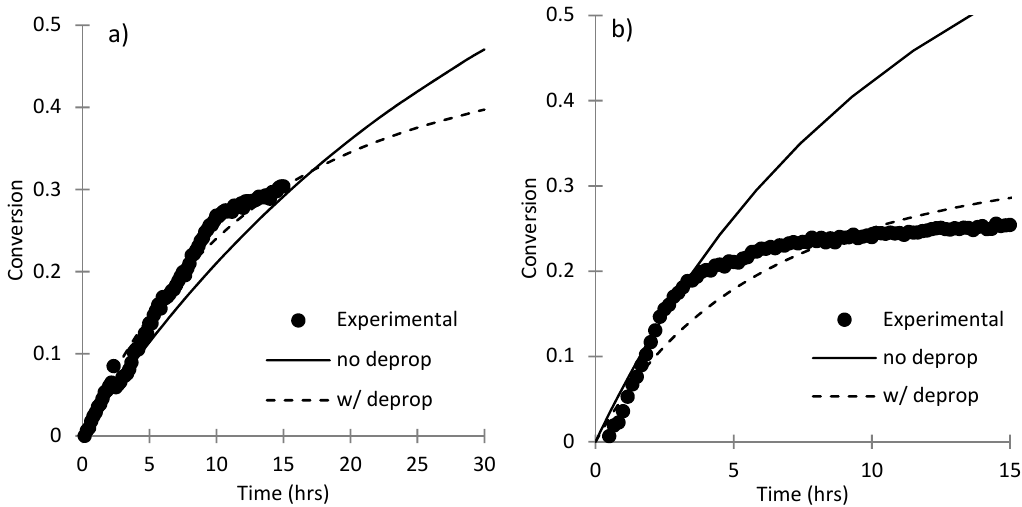
Figure 8. Conversion profile of SHMeMB homopolymerization with 15 wt % monomer and 1 wt % V-86 at ( a ) 75 °C and ( b ) at 90 °C. Lines indicate best-fit simulation results with (- - - - ) and without ( ―― ) depropagation.